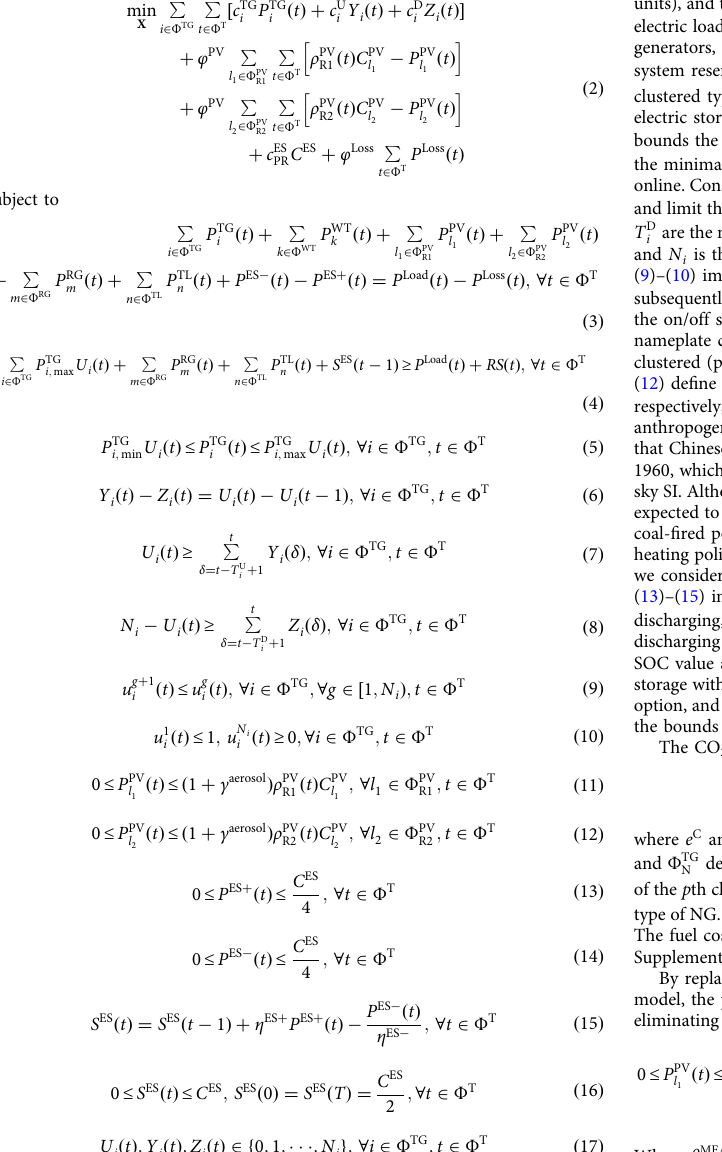
Supplementary Table 4. By replacing constraint (11) with constraint (19) and re-optimizing the CUC model, the power system operation status and corresponding carbon emissions eliminating any plum rain effects can be